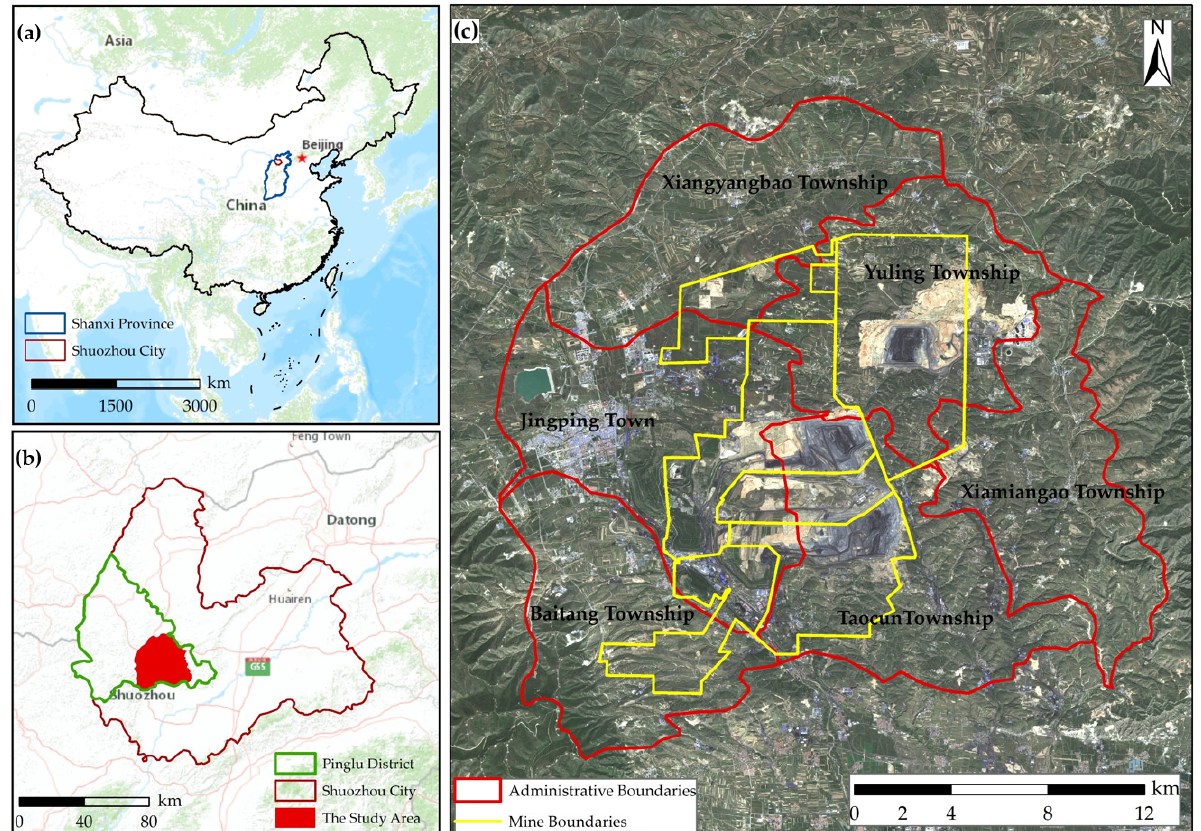
Figure 1. The location of the mine–agriculture–urban compound area. (The base maps of ( a , b ) are the color version of the map of China that comes with ArcGIS, the base map of ( c ) is the 2020 Landsat remote sensing image data that was from United States Geological Survey (https://earthexplorer.usgs. gov/ accessed on 3 March 2022), and the figure was made by Shufei